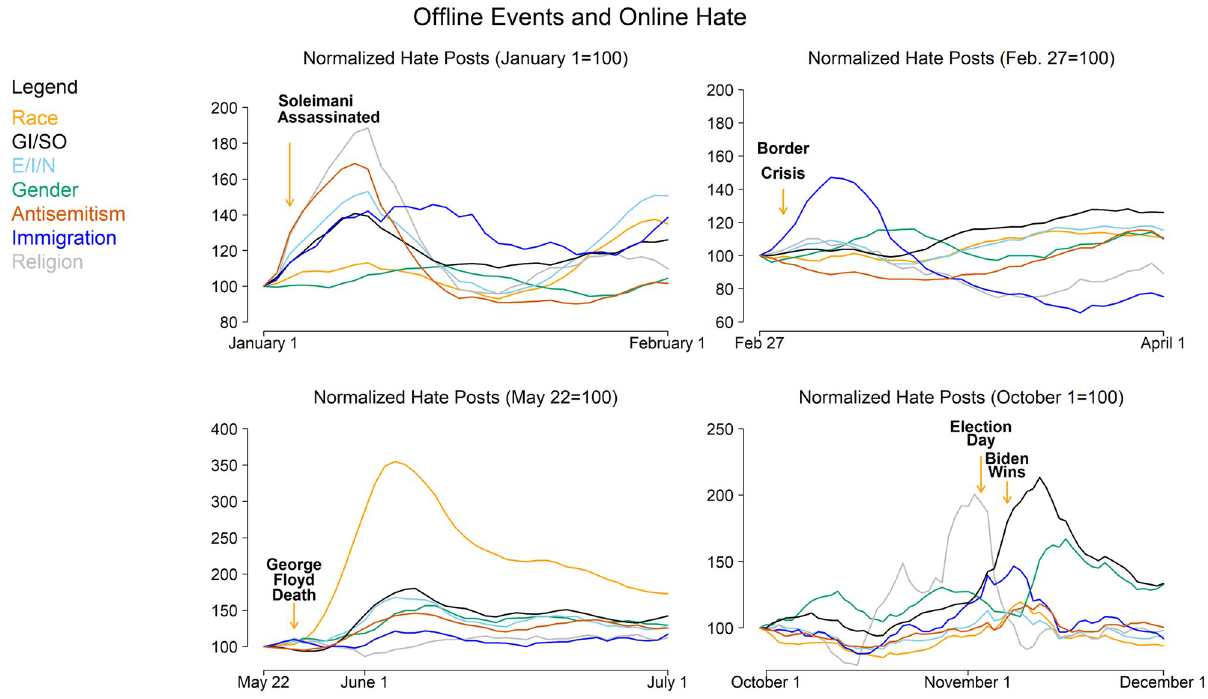
Fig 4. Offline events and online hate. Each panel shows the changes in the relative levels of each type of hate speech following a trigger